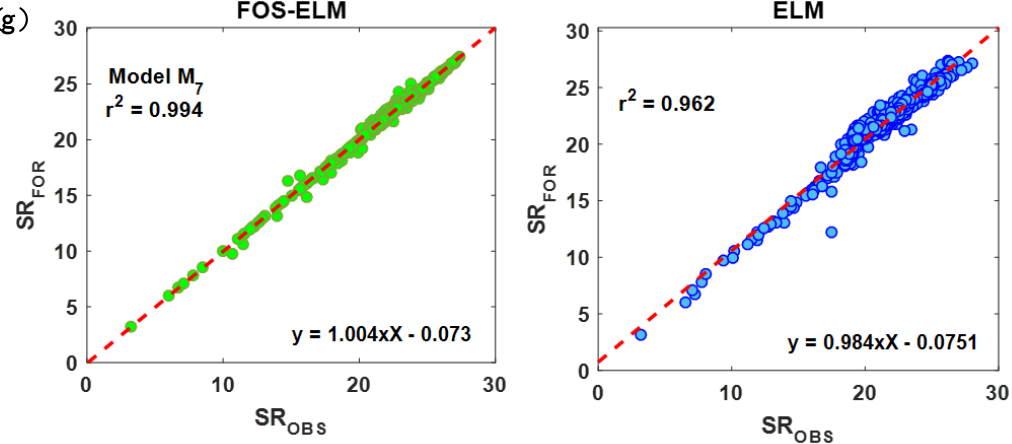
Figure 5. Scatterplots variance between the observed and predicted solar radiation over the test modeling phase, variable forgetting factor (FOS-ELM) vs. extreme learning machine (ELM) models and for all the investigated input combination panels ( a ) M 1 , ( b ) M 2 , ( c ) M 3 , ( d ) M 4 , ( e ) M 5 , ( f ) M 6 and ( g ) M 7 .